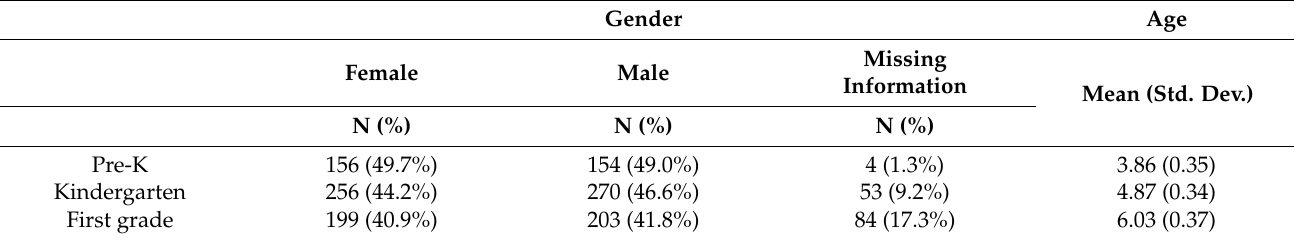
Table 1. Participant